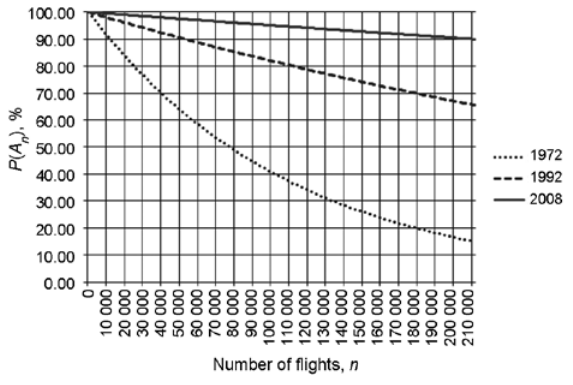
Fig. 2. The probability of carrying out n safe flights for a given passenger in 1972, 1992 and